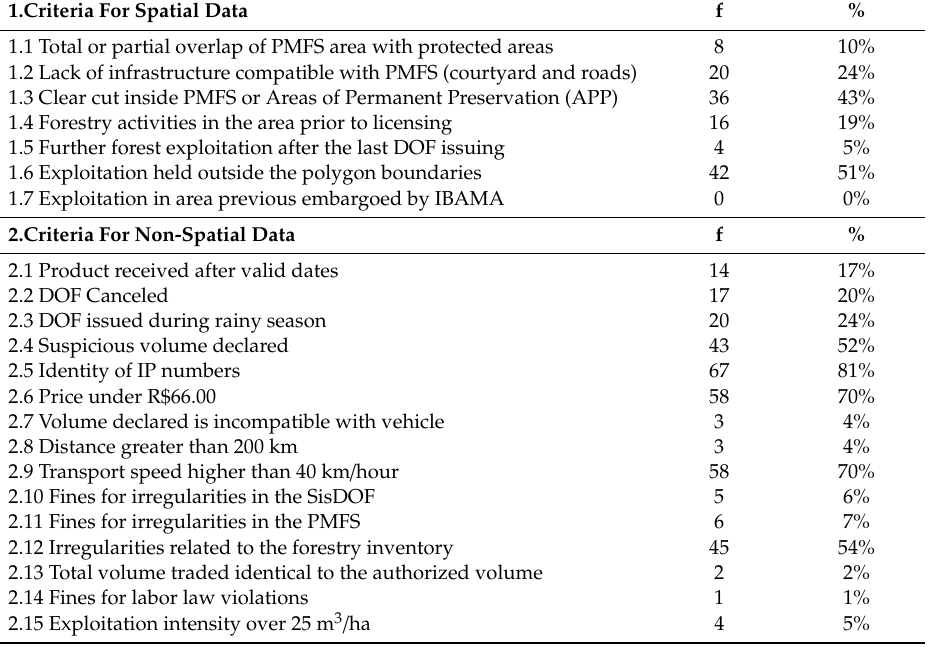
Table 3. Frequency (f) and percentage (%) of irregularities / signs of fraud.